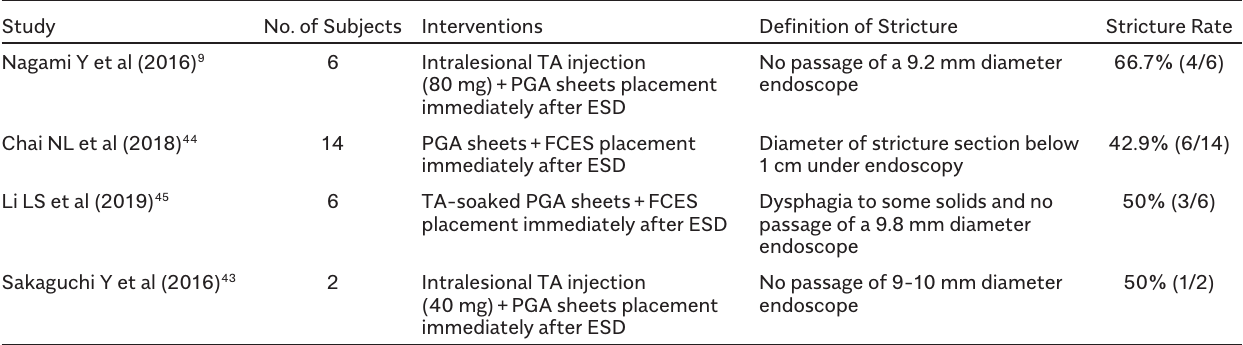
Table 3. Studies on PGA Combined Other Treatments for Prevention of Esophageal Stricture After Whole Circumferential Endoscopic Resection